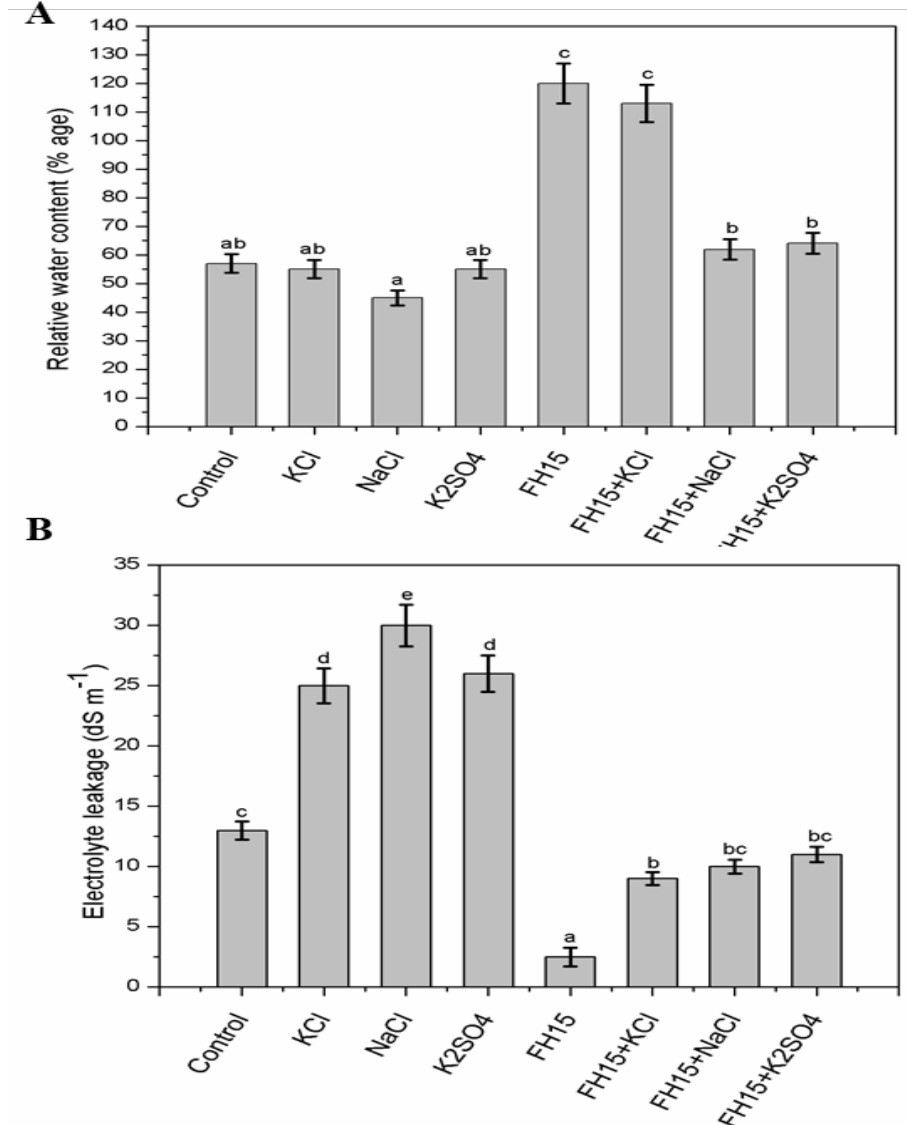
Figure 4. Effect of different salts on ( A ) relative water content and ( B ) electrolyte leakage of maize with or without endophytic fungal strain C. membranifaciens FH15. The bars represent mean with ± SE and the different letters on the bars represent significance at p = 0.05.